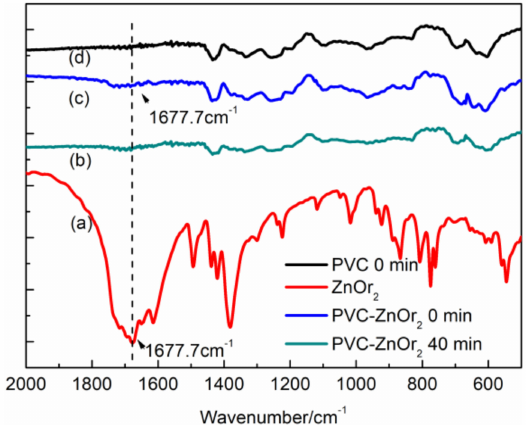
Figure 7. The FTIR spectra of PVC degradation process. ( a ) ZnOr 2 , ( b ) PVC/ZnOr 2 —40 min, ( c ) PVC/ ZnOr 2 —0 min, ( d )